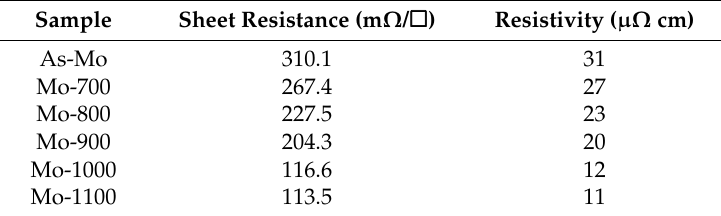
Table 2. Summary of sheet resistance and resistivity of Mo thin films, as a function of annealing temperature.